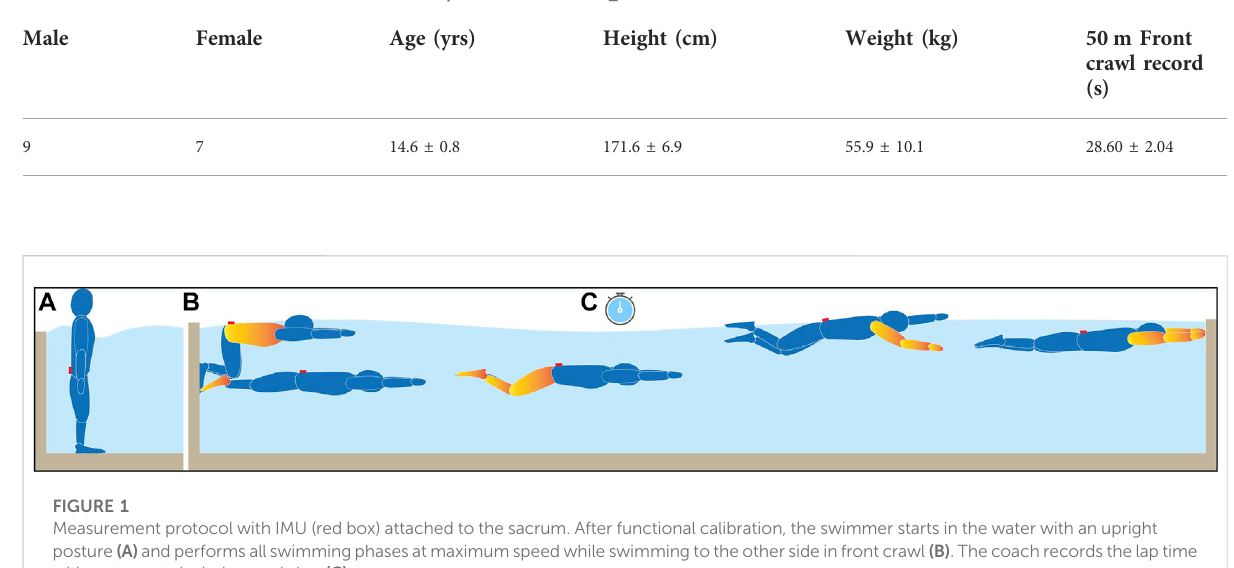
TABLE 1 Statistics of the swimmers. The values are presented as mean ± standard deviation.